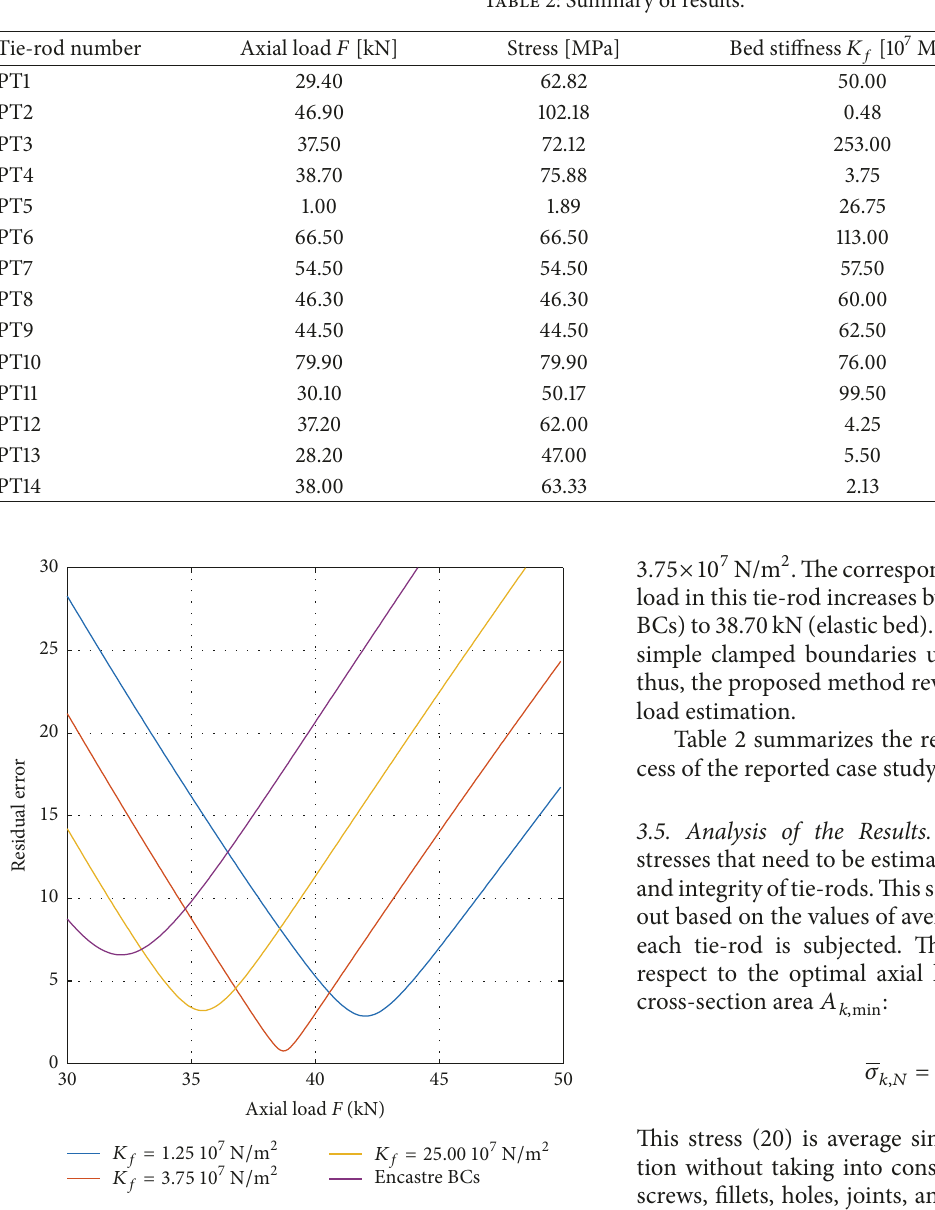
Table 2: Summary of results.